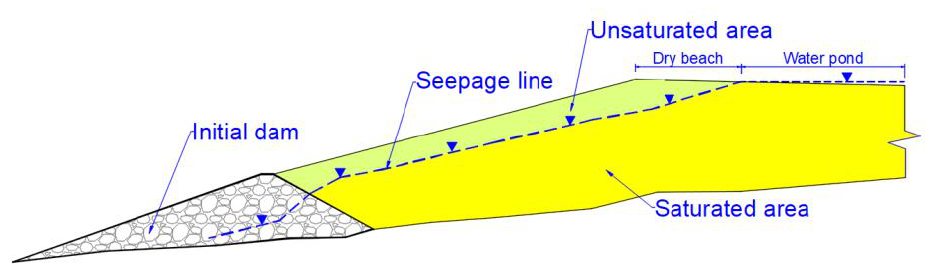
Figure 2. Schematic of an upstream tailings dam structure.